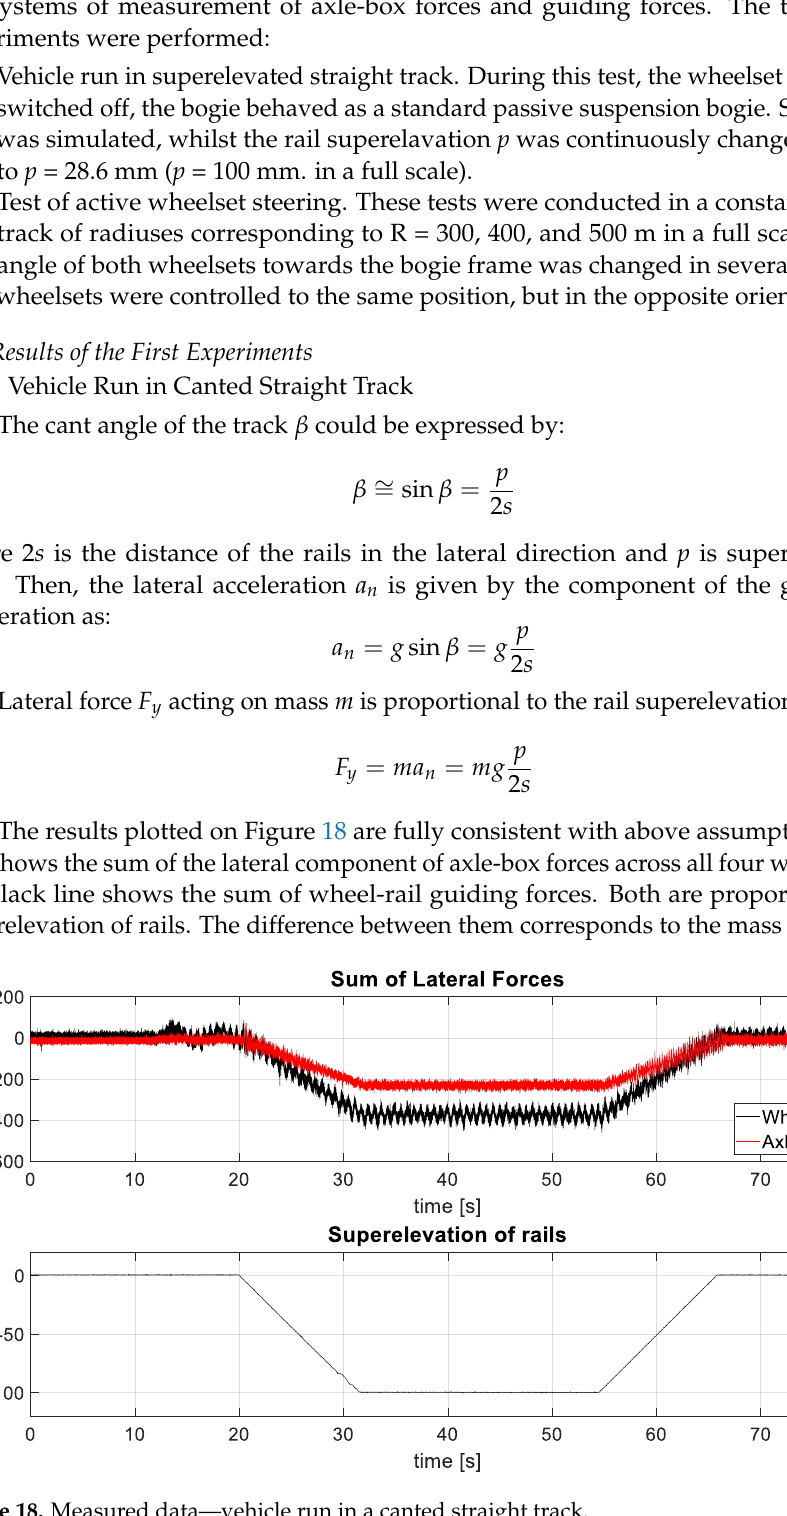
Figure 18. Measured data—vehicle run in a canted straight